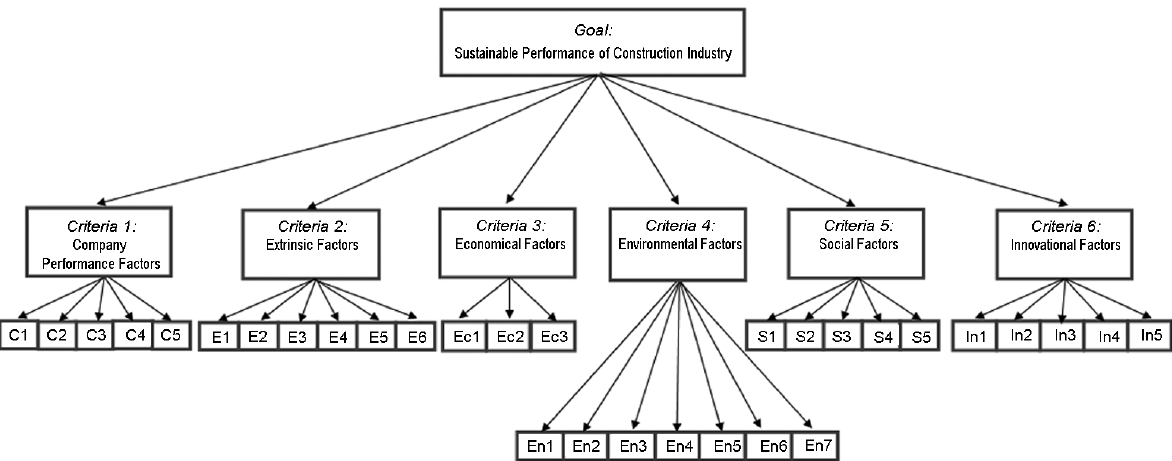
Fig. 1. AHP model structure